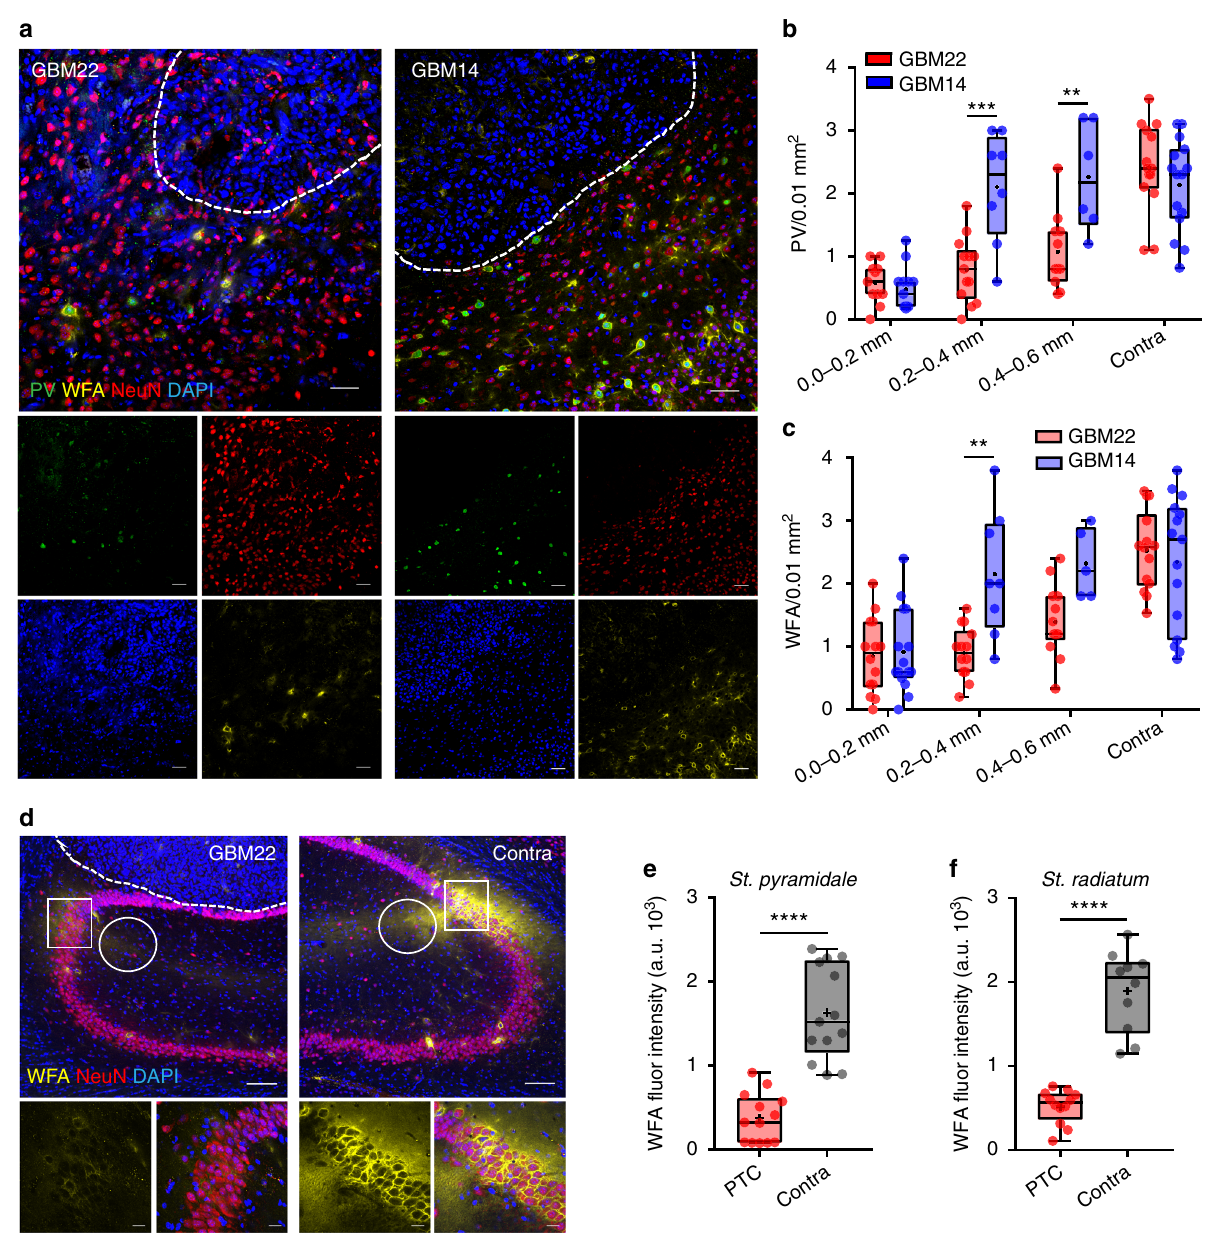
Fig. 3 Differential effects of epileptogenic GBM22 and nonepileptogenic GBM14 gliomas on cortical PV + neurons and PNNs in the PTC. a Representative confocal images of DAPI (blue), PV (green), PNN (yellow), and NeuN (red) immuno fl uorescence in the PTC of GBM22 (left) and GBM14 (right). Scale = 20 µ m. b Peritumoral PV + cells density in GBM22 and GBM14 slices at 0.0 – 0.2 mm (GBM22, 0.58 ± 0.1; GBM14, 0.48 ± 0.1), 0.2 – 0.4 mm (GBM22, 0.79 ± 0.14; GBM14, 2.1 ± 0.31), and 0.4 – 0.6 mm (GBM22, 1.08 ± 0.18; GBM14, 2.26 ± 0.35) distance from the tumor ( n = 6 mice in each bin). c The density of PNN + cells in the PTC of GBM22 and GBM14 slices at 0.0 – 0.2 mm (GBM22, 0.85 ± 0.16; GBM14, 0.91 ± 0.17), 0.2 – 0.4 mm (GBM22, 0.9 ± 0.11 ; GBM14, 2.15 ± 0.35), and 0.4 – 0.6 mm (GBM22, 1.40 ± 0.16 ; GBM14, 2.32 ± 0.25). n = 6 mice in each bin. The density of PV + neurons ( b ), and PNNs (WFA) ( c ) beyond 0.6 mm PTC in GBM14 and GBM22 was not signi fi cantly different from contralateral and sham. n = 6 mice. d Representative confocal images of DAPI (blue), PV + (green), PNN + (yellow), and NeuN (red) immuno fl uorescence from GBM22-implanted ipsilateral and contralateral hippocampal slices. Scale = 100 µ m top and 20 µ m bottom images. e WFA intensity in CA2 PNNs (peritumoral, 376.8 ± 81.12; contralateral, 1628 ± 155.2) n = 4 mice. f WFA intensity in stratum radiatum (peritumoral, 517.7 ± 57.66; contralateral, 1894 ± 153.2) n = 4 mice. All fl uorescence intensities represent arbitrary units of fl uorescence. **** P < 0.0001,*** P < 0.001, ** P < 0.01, two-way ANOVA, Tukey ’ s post-hoc test in ( b ) and ( c ); Welch ’ s t test in ( e ) and ( f